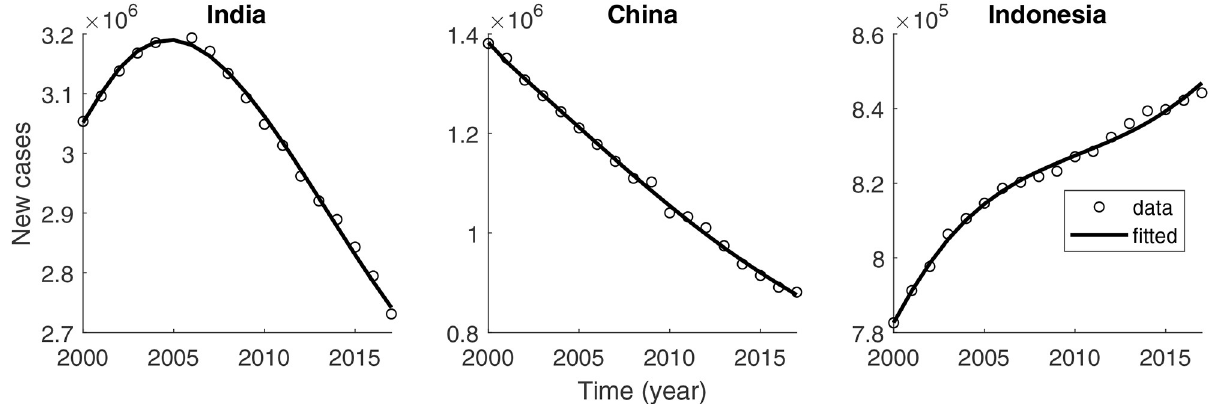
Fig 3. Reported numbers of incident cases (circle) and corresponding best fitted curves of κ E ( t ) (solid) in top three TB burden countries.